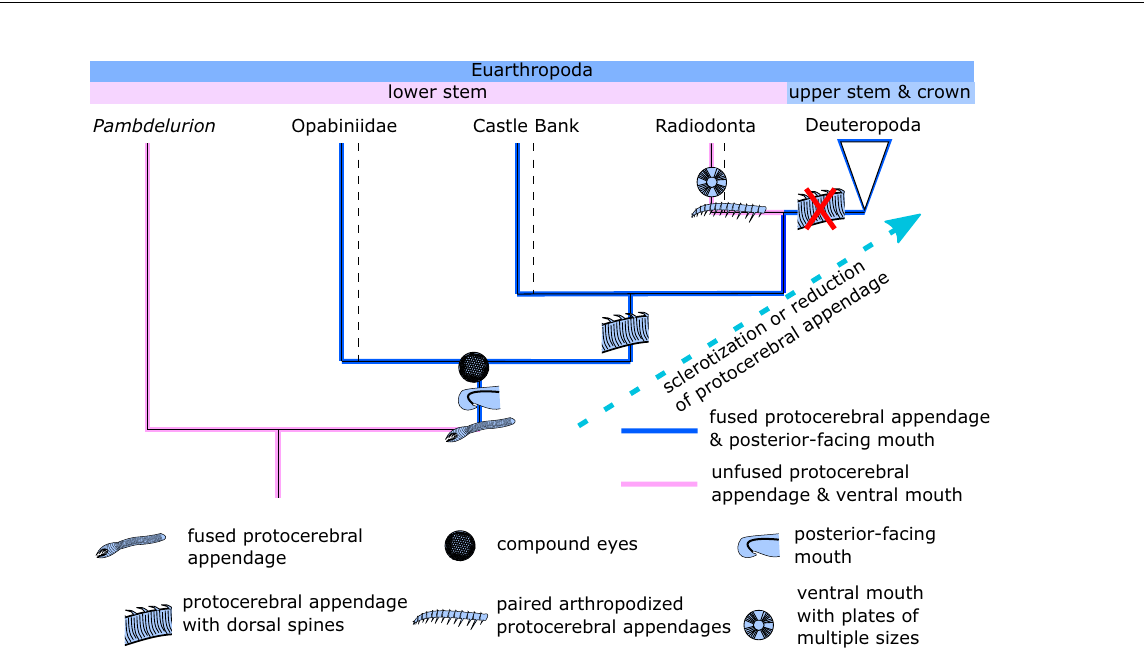
paraphyletic relationships. Full phylogenetic results provided in Supplementary Figs. 6 – 11.